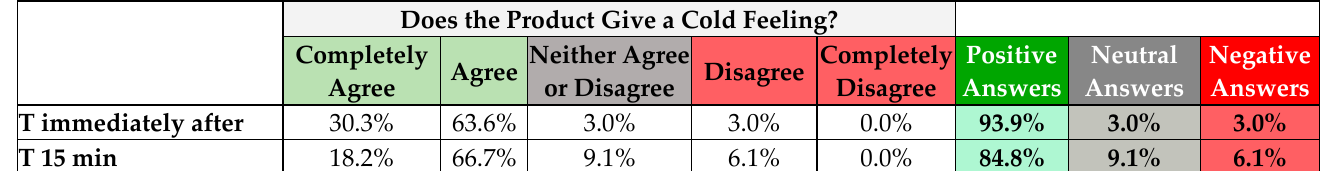
Table 3. Subjective evaluation of the cooling effect of the product on sunburn 1 (first sunburn treated with FC